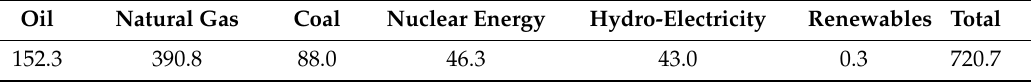
Oil Natural Gas Coal Nuclear